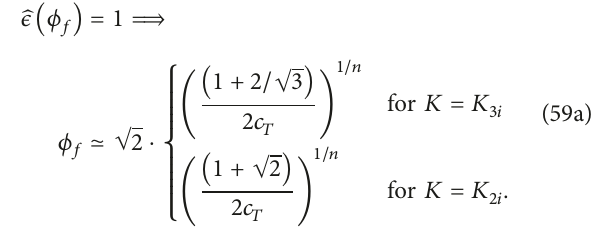
Figure 2: The ratio ̂𝑚 2 𝑠 corresponding to 𝜙 ⋆ and 𝜙 𝑓 are also